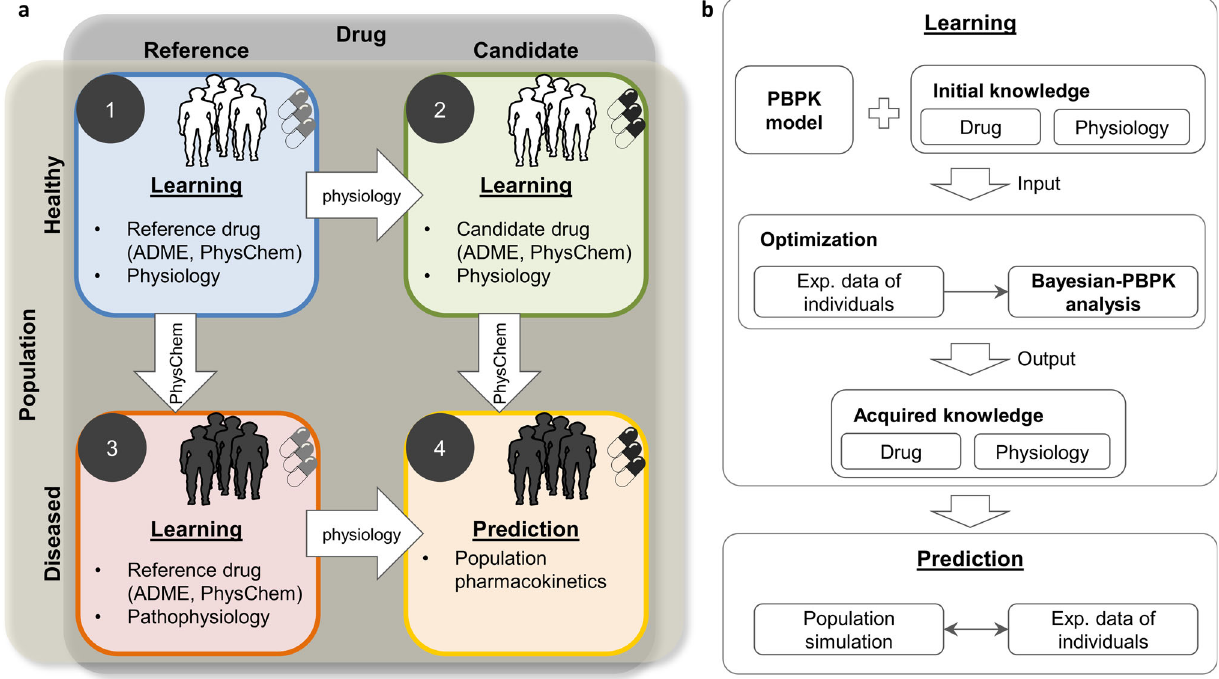
Fig. 1 Schematic illustration of the translational approach. a A learning step contains a full Bayesian analysis where initial knowledge is used in combination with new experimental data to re fi ne and acquire knowledge about physiological and drug-speci fi c parameters. A